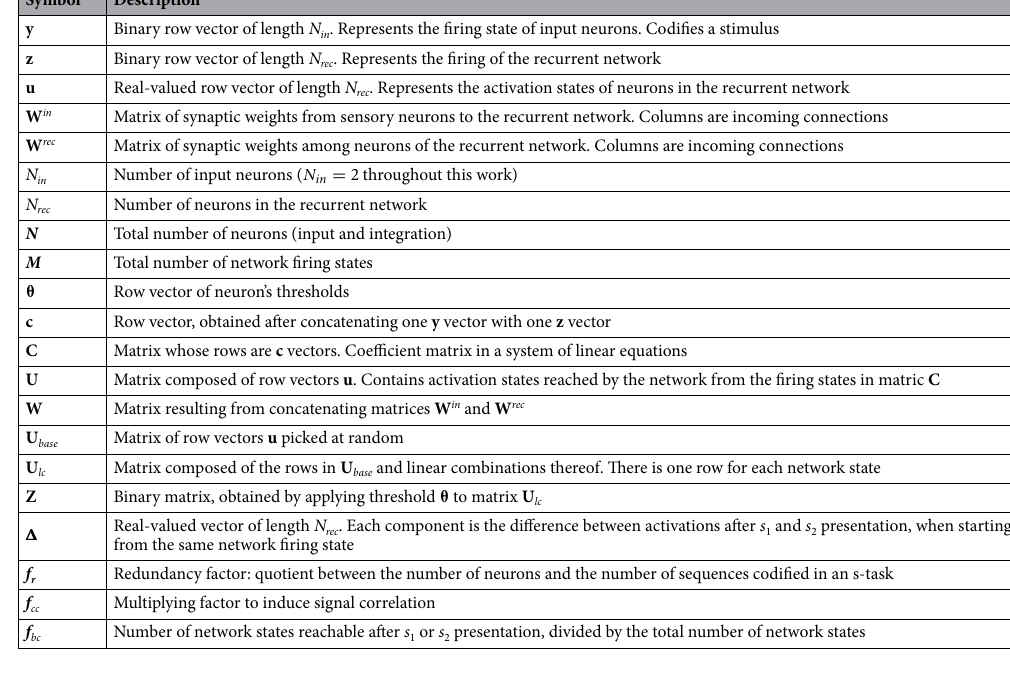
Table 1. Symbols with